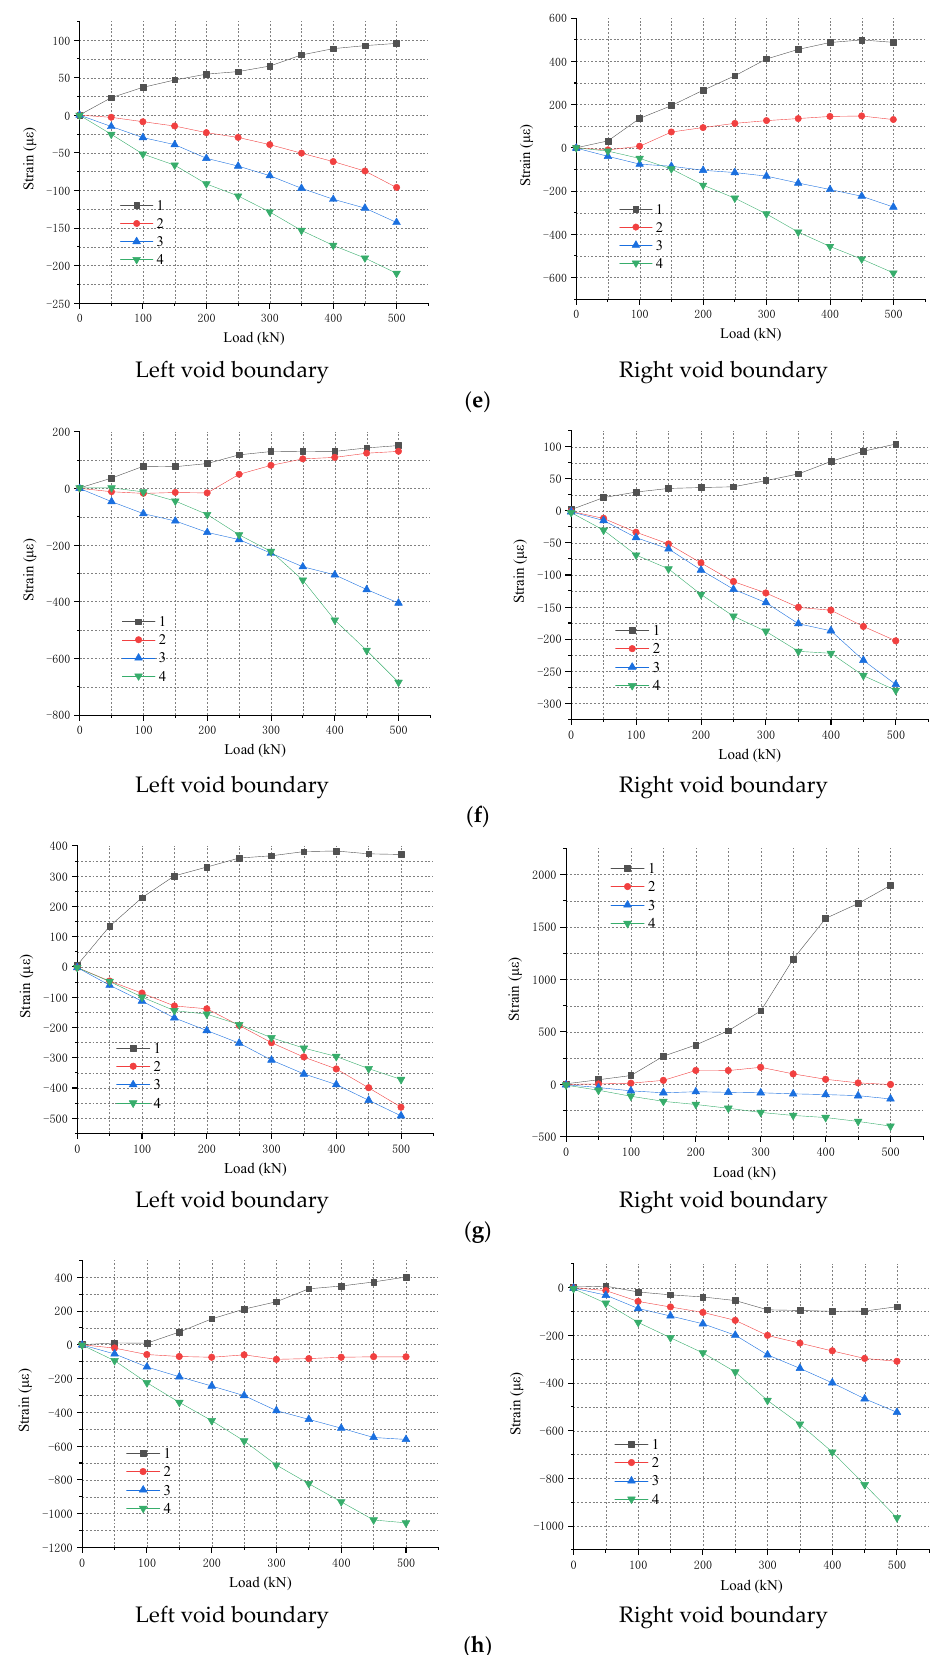
Figure 11. The lateral strain of void boundary. ( a ) V1/4; ( b ) V1/3; ( c ) V1/2; ( d ) V2/3; ( e ) R1/4; ( f ) R1/3; ( g ) R1/2; ( h ) R2/3.